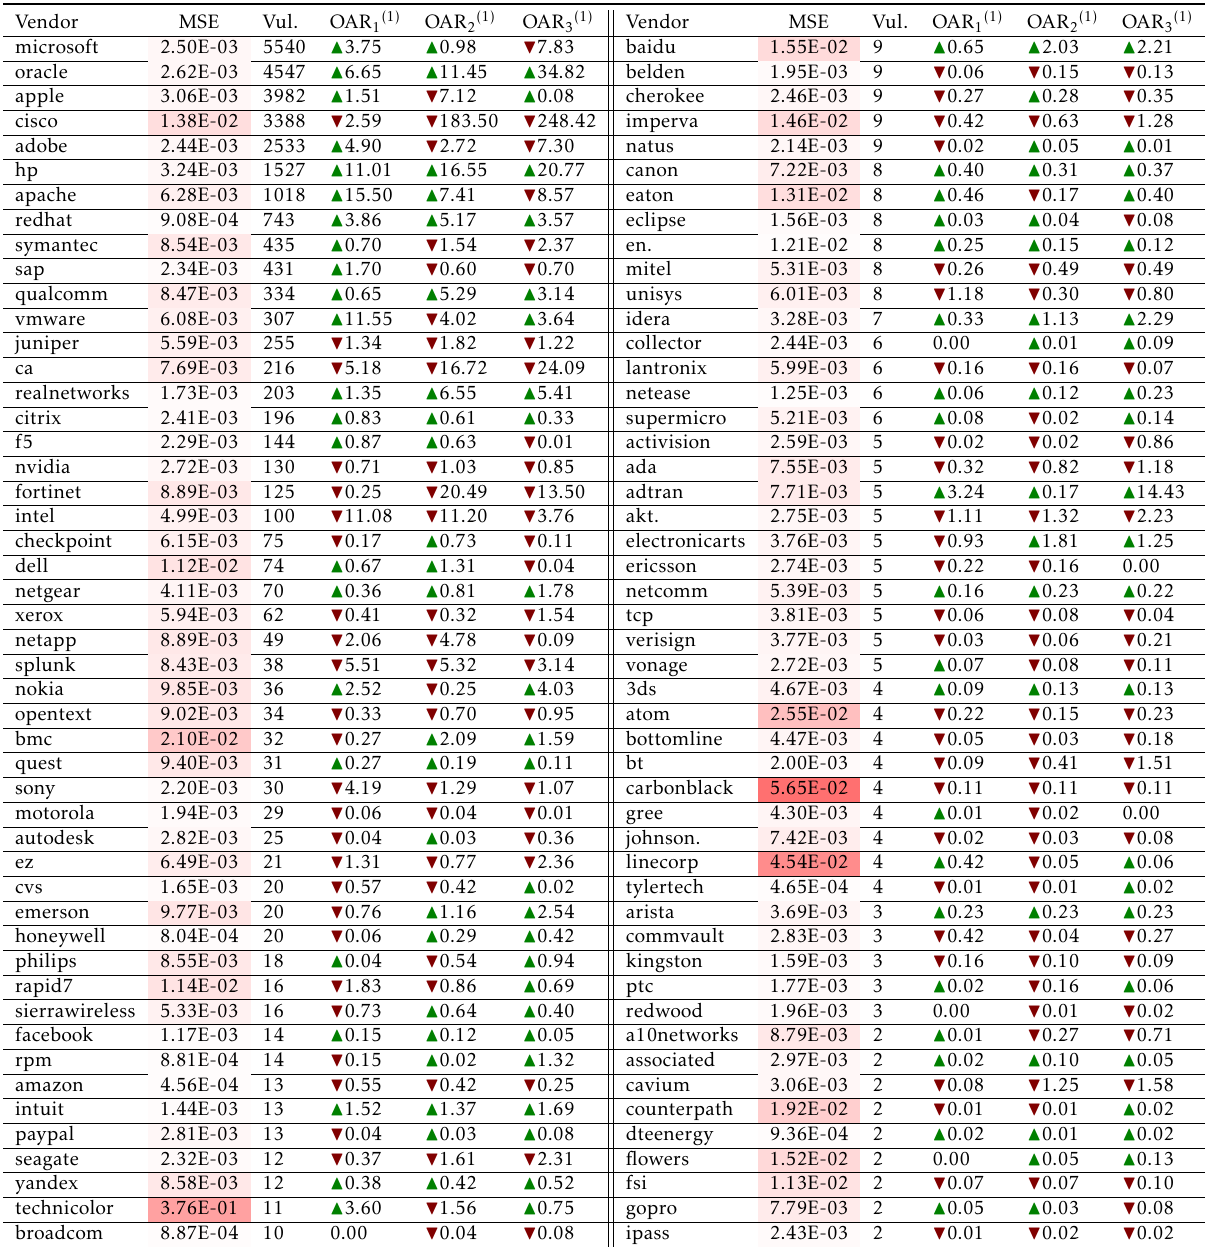
Table 3. Results for each Vendor. Vul.: vulnerability count, OAR (percent), respectively. (2) Vendor names are abbreviated as follows: ls.=Lattice Semiconductor, ra.=rockwellautomation, akt.=Akamai Technologies, en.=Extreme Networks, johnson.=johnsoncontrols. (cid:78) : vulnerabilities had no overall impact on vendor’s stock value. (cid:72) : the stock of the vendor were